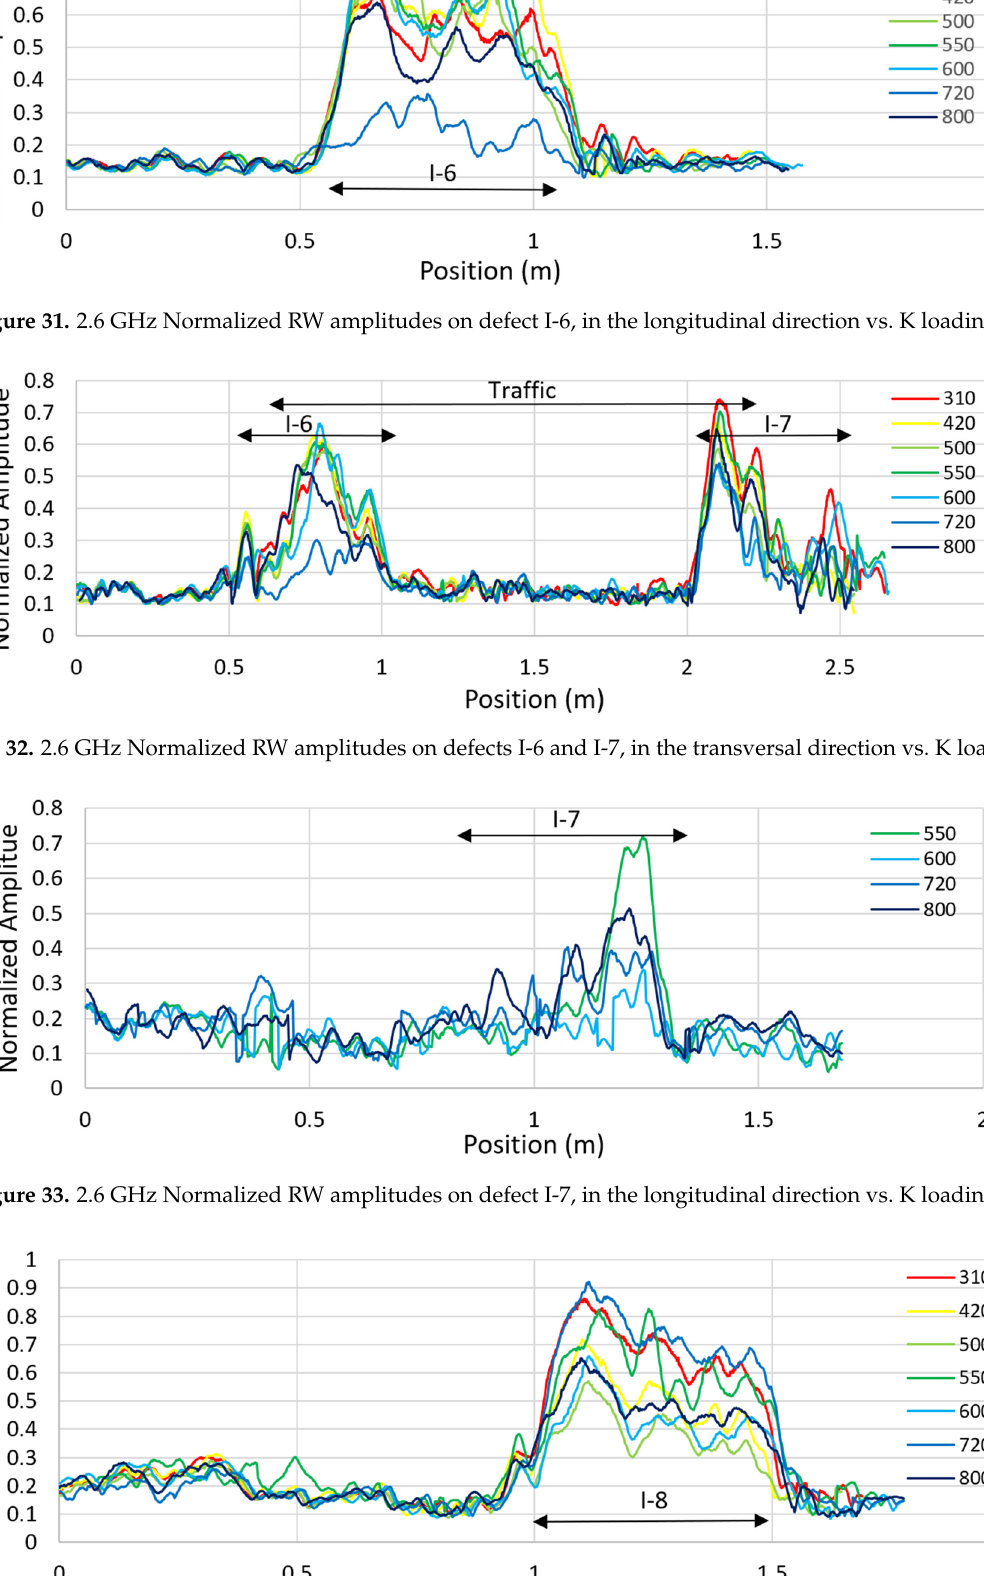
Figure 35. 2.6 GHz Normalized RW amplitudes on defect I-8, in the transversal direction vs. K loadings. Figure 36. 2.6 GHz Normalized RW amplitudes on defect I-9, in the transversal direction vs. K loadings. Figure 37. 2.6 GHz Normalized RW amplitudes on defects I-9 and I-10, in the longitudinal direction vs. K loadings.